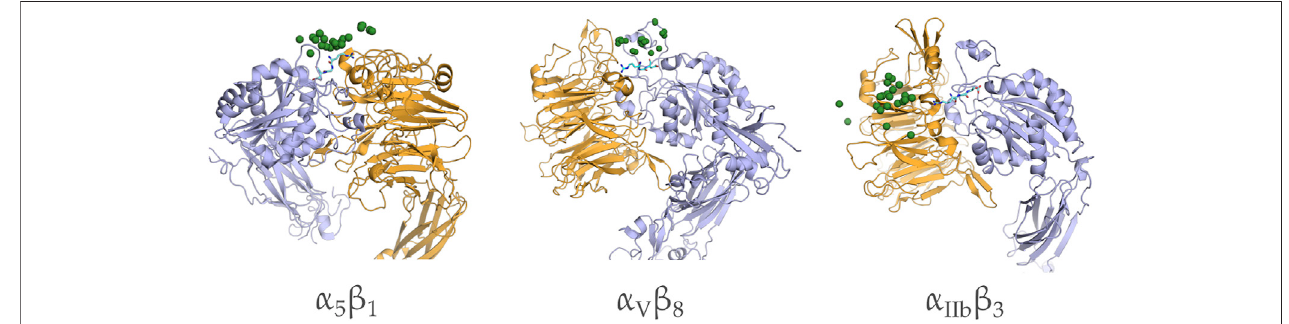
FIGURE 5 | Distribution of the candidate complexes of RBD docked to α 5 β 1 , α IIb β 3 , and α V β 8 integrins. The positions of G405 of the RBD motif are shown in green spheres and the native bound con fi guration of RBD from the crystal structure is shown in cyan